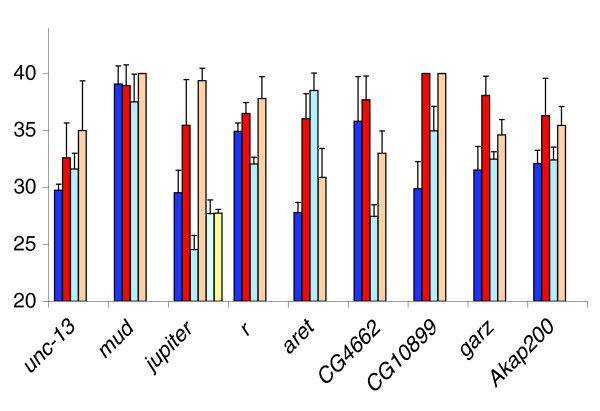
Sex-specific amplification of alternative transcripts from nine genes that showed significant sex by probe interaction in the microarray data (unc-13, mud, jupiter, r, aret, CG4662, CG10899, garz, Akap200; see Table 3). The graph shows the average CTs for each exon junction in males and females of the OregonR line. CT values were calculated by performing qPCR with SYBR® Green I dye chemistry on three bioreplicates consisting of four virgin males and females, and correspond to the number of cycles when the fluorescence intensity was significantly above background during the exponential phase of amplification; dark blue, male transcript 1; light blue, male transcript 2; green, male transcript 3; red, female transcript 1; pink, female transcript 2; orange, female transcript 3.